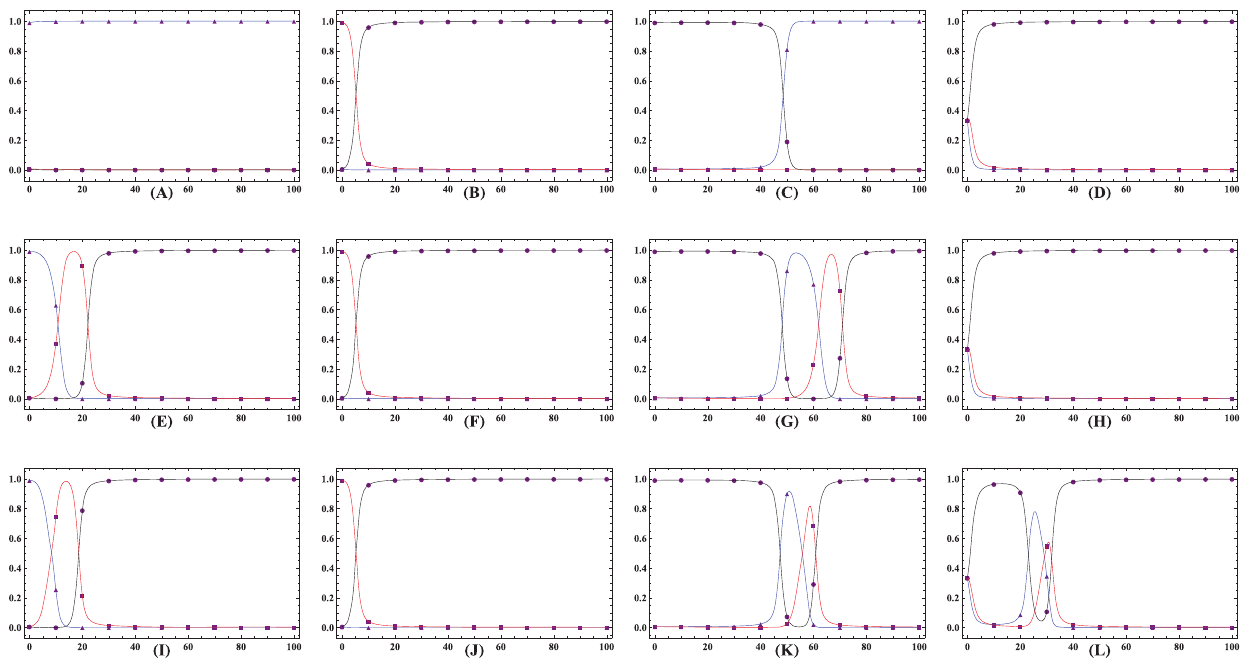
Figure 2. Population dynamics whenever cooperators defectors, and loners compete to survive. The lines embedded with solid triangle, square, and circle represent the evolutionary trajectories of cooperators, defectors and loners, respectively. For r ~ 3 , in both the linearly-dependent and sigmoidally-dependent patterns, the evolution share the property that when cooperators abound, it is better to defect, while defectors’ prosperity puts the loners in the advantageous place forever, and thus loners take over the whole population. In the inverse sigmoidally-dependent pattern, loners do thrive ensuing the defectors’ abundance. An exception emerges while the population consists of most cooperators, it drives to the full cooperative state. Loners win the evolutionary race when the population starts with a state in which cooperators and defectors, and loners have the same share. Parameters N ~ 10 , r ~ 3 . Upper row m ~{ 0 : 4 , middle row m ~ 0 , and low row m ~ 10 .